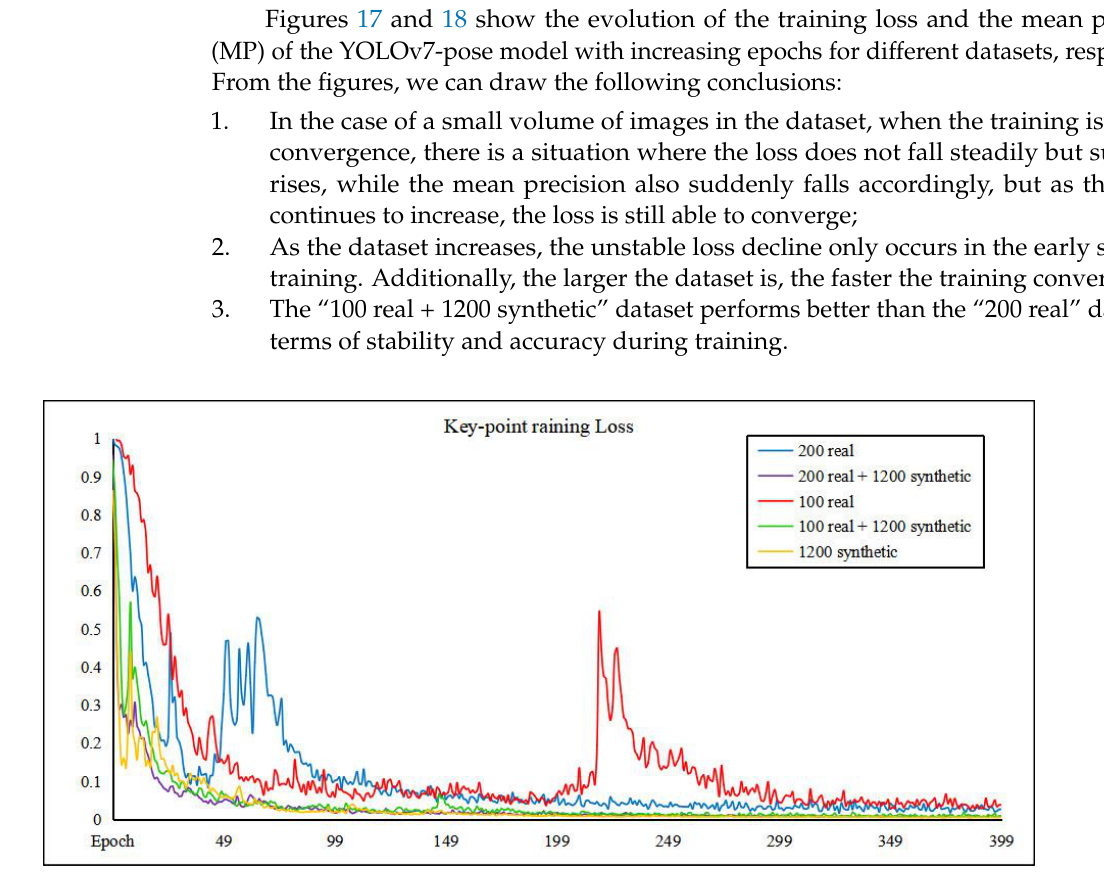
Figure 17. The training loss for different datasets.